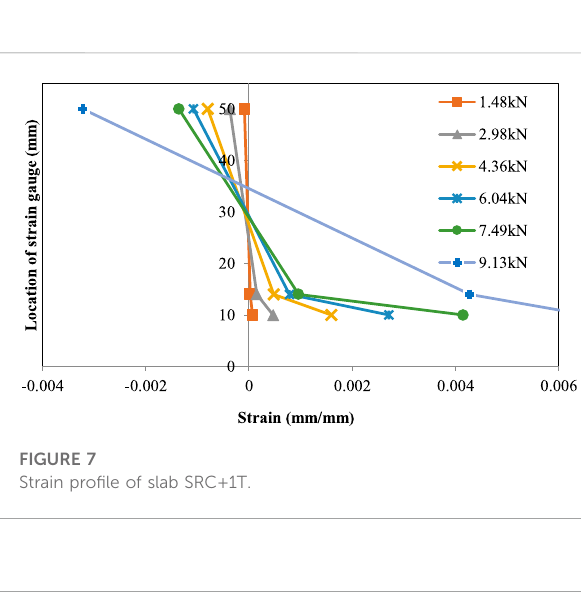
FIGURE 6 Strain pro fi le of slab SRC.